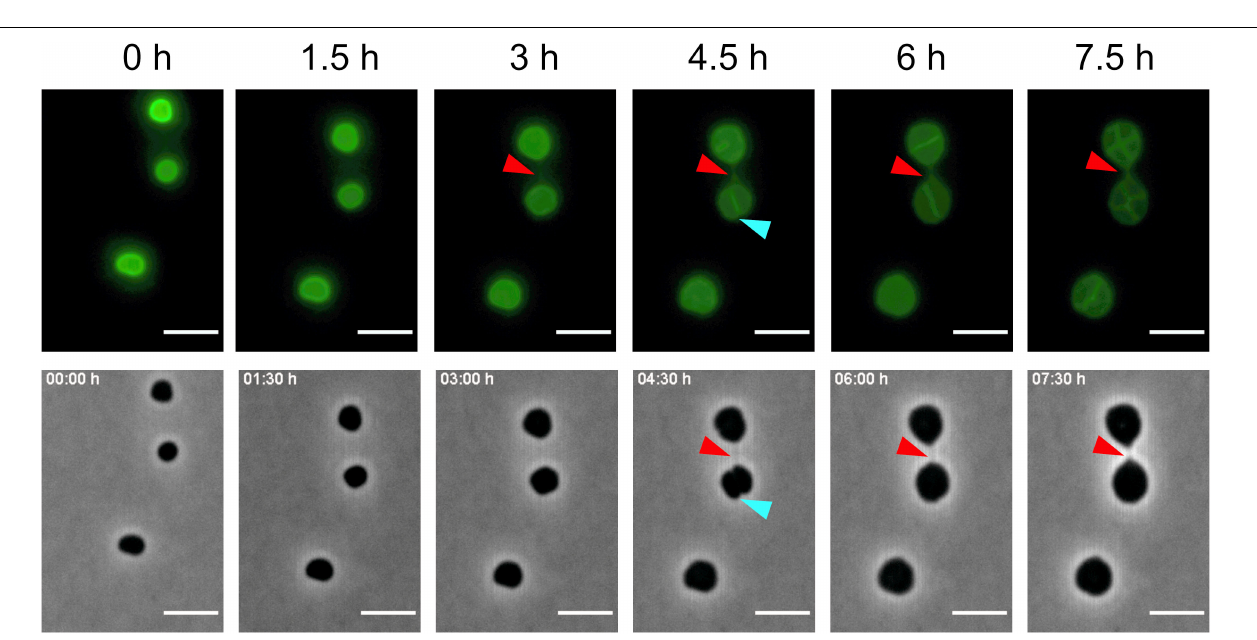
FIGURE 5 | Formation of a cell–cell bridge followed by fluorescence microscopy. Time-lapse fluorescence images of AlexaFluor488 labeled H. volcanii cells with the corresponding phase-contrast image. The fluorescence signal for the cell–cell bridge can be detected after 5 h and is indicated by a red arrow. In phase contrast, the cell–cell bridge can be detected after 7 h. Blue arrows indicate the septum formed between the cells due to a cell division defect. Scale bars are 4 µ